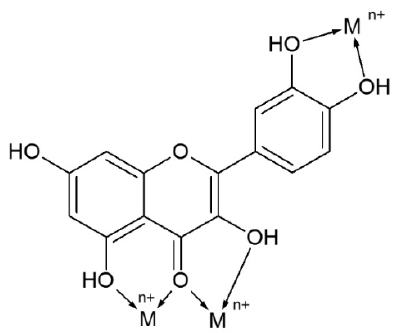
Figure 5. Metal chelation by quercetin—possible chelating sites.